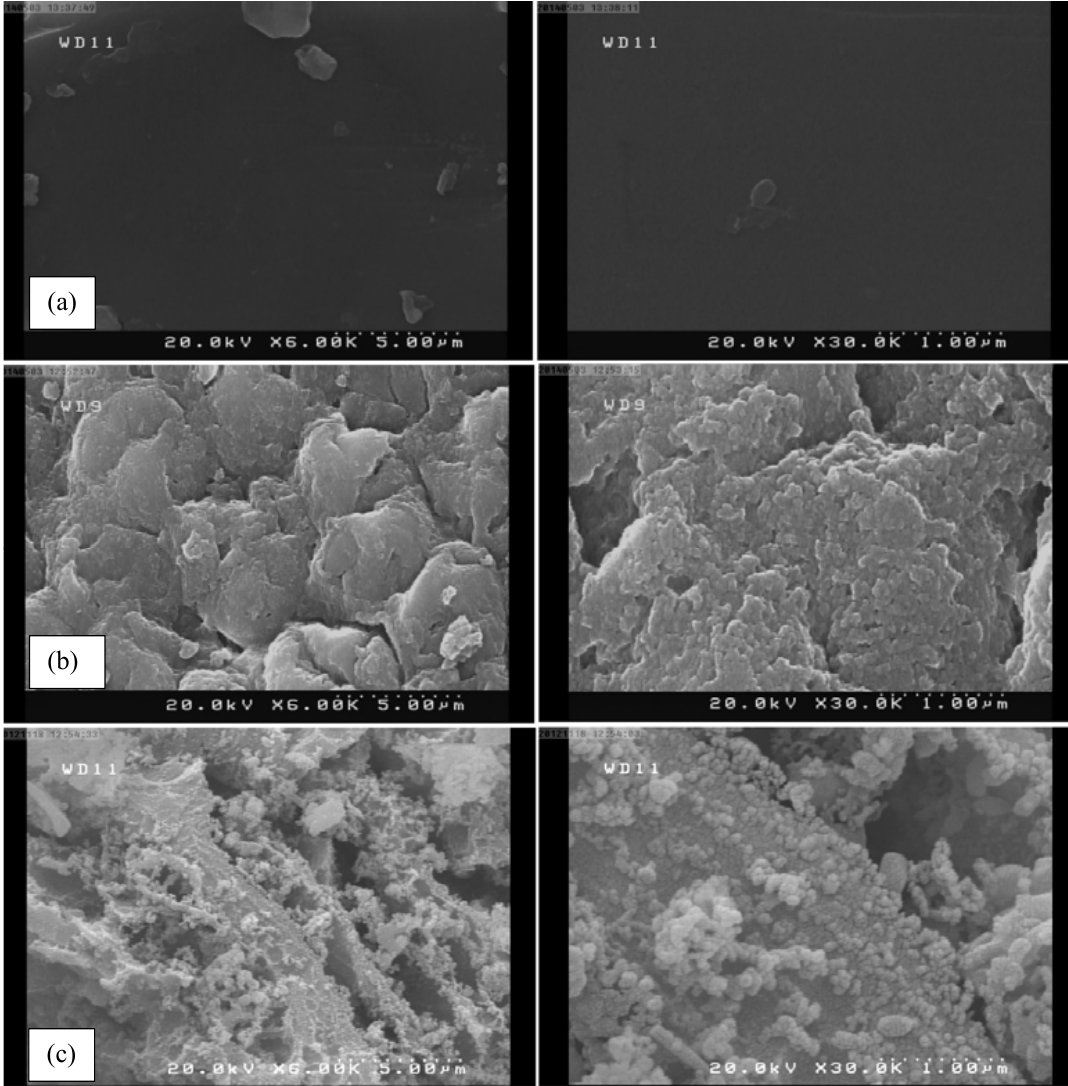
Fig. 2. FESEM image of (a) Raw M (b) activated carbon and (c) Fe